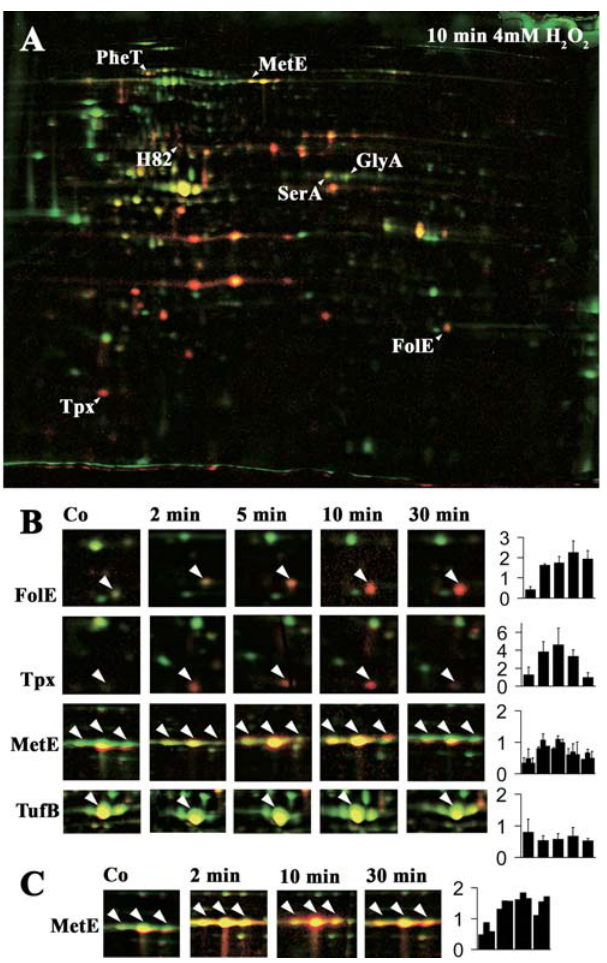
Figure 5. Identification of Oxidative Stress–Sensitive Proteins In Vivo (A) Overlay of the stained 2D gel (shown in green) and the phosphor image (shown in red) of differentially trapped protein extracts from H 2 O 2 -stressed E. coli wild-type cells. Proteins that were found to have a significantly higher ratio of 14 C activity/protein after 10 min of H 2 O 2 treatment than in untreated cells are labeled. (B) Time course of the oxidation of proteins in E. coli wild-type cells upon treatment with H 2 O 2 . Details of the colored overlays of stained protein gels (shown in green) and phosphor images (shown in red) of cell extracts taken before (Co) and 2, 5, 10, and 30 min after addition of H 2 O 2 to the cells. The selected proteins are FolE, Tpx, MetE, and TufB. Bar charts on the right show the oxidation-dependent change in ratio of 14 C activity/protein of the protein spot labeled by an arrowhead. (C) Time course of the oxidation of MetE in E. coli wild-type cells upon treatment with 1 mM diamide. Details of the colored overlays of stained protein gels (shown in green) and autoradiographs taken on X-ray films (shown in red) of cell extracts taken before (Co) and 2, 10, and 30 min after addition of diamide to the cells. DOI: